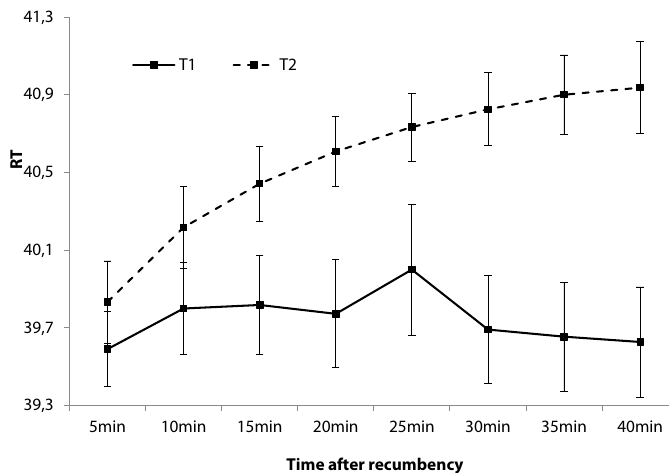
Rectal temperature (RT) was significantly higher in blesbok treated with T2 than those